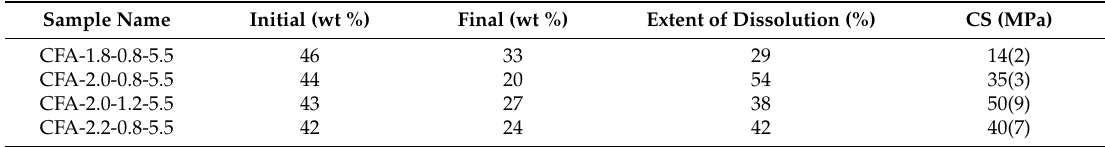
Table 3. The refined d-spacings of the flyash and geopolymer amorphous phase peaks. The geopolymer amorphous phase peak positions are smaller than found for the metakaolin geopolymer [33] which were between 3.15 and 3.22 Å. The flyash amorphous phase peak position was allowed vary between samples in the refinement.